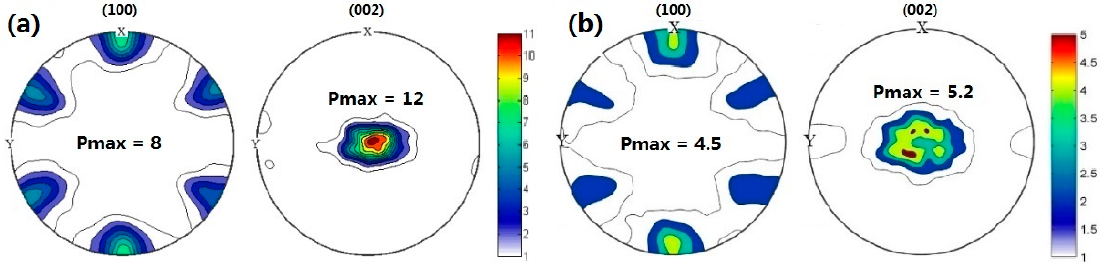
Figure 11. Simulated pole figures at 20% strain: ( a ) Z1 along RD; ( b ) ZN10 along